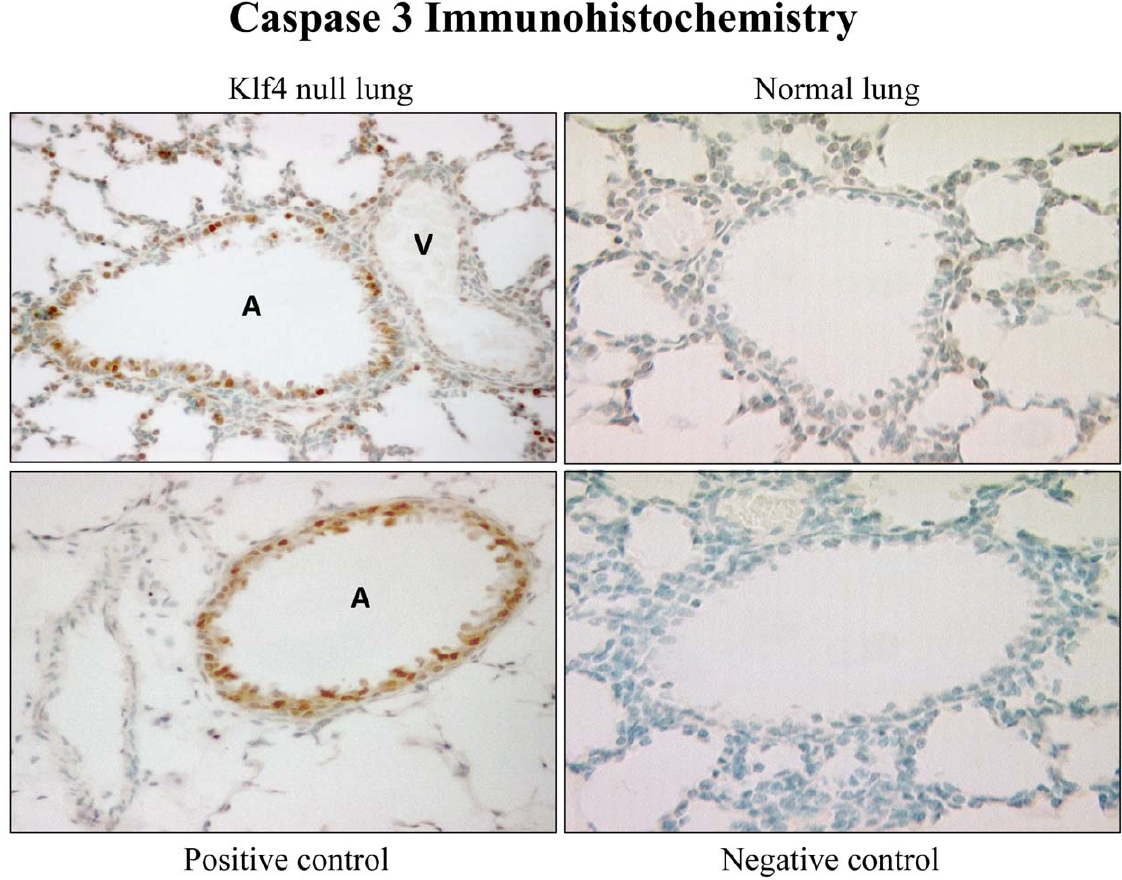
Figure 12. Lung cell apoptosis at birth. An intense nuclear immunohistochemical signal (brown color) for caspase-3 protein is present in numerous airway epithelial (A) and surrounding interstitial cells but absent from vascular (V) cells in Klf4 null mouse lung (top left panel). Few cells (arrow) of the normal lung exhibit signal (top right panel). Signal limited to airway epithelial (A) cells in hyperoxia-exposed GGT enu1 lung as a positive control [13] (bottom left panel). No signal with omission of primary antibody as the negative control (bottom right panel).